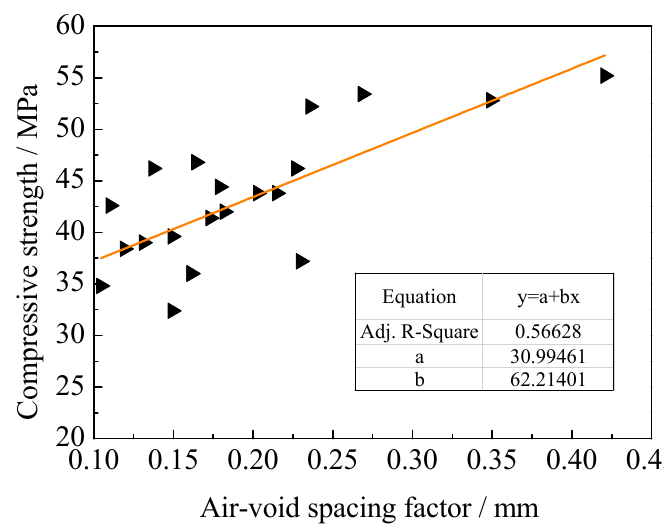
Figure 12. Effect of the air-void spacing factor on the compressive strength of hardened concrete. Figure 12. E ff ect of the air-void spacing factor on the compressive strength of hardened